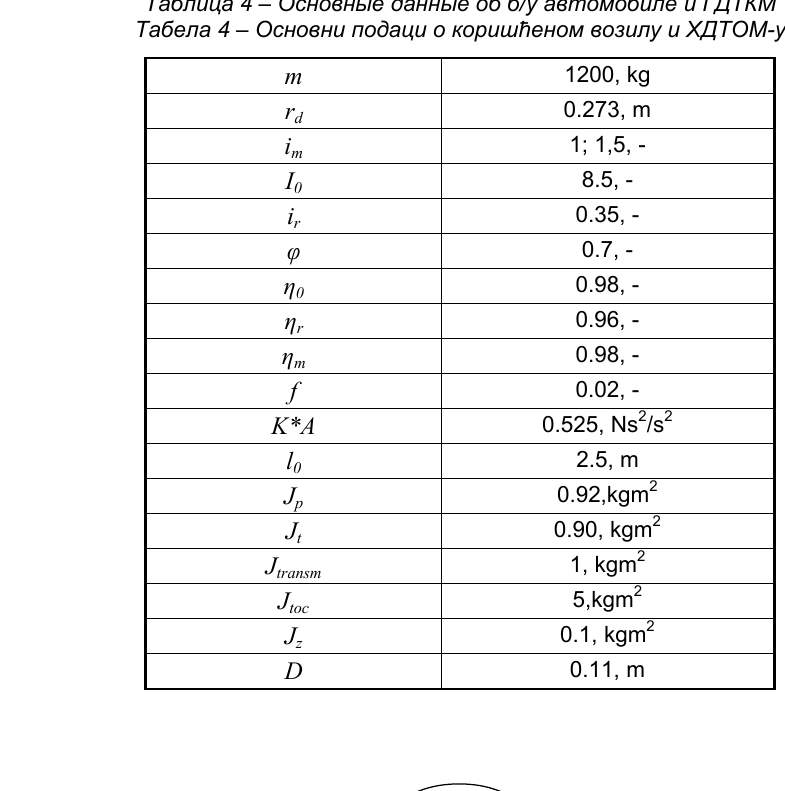
Table 4 – Basic data on the used vehicle and the